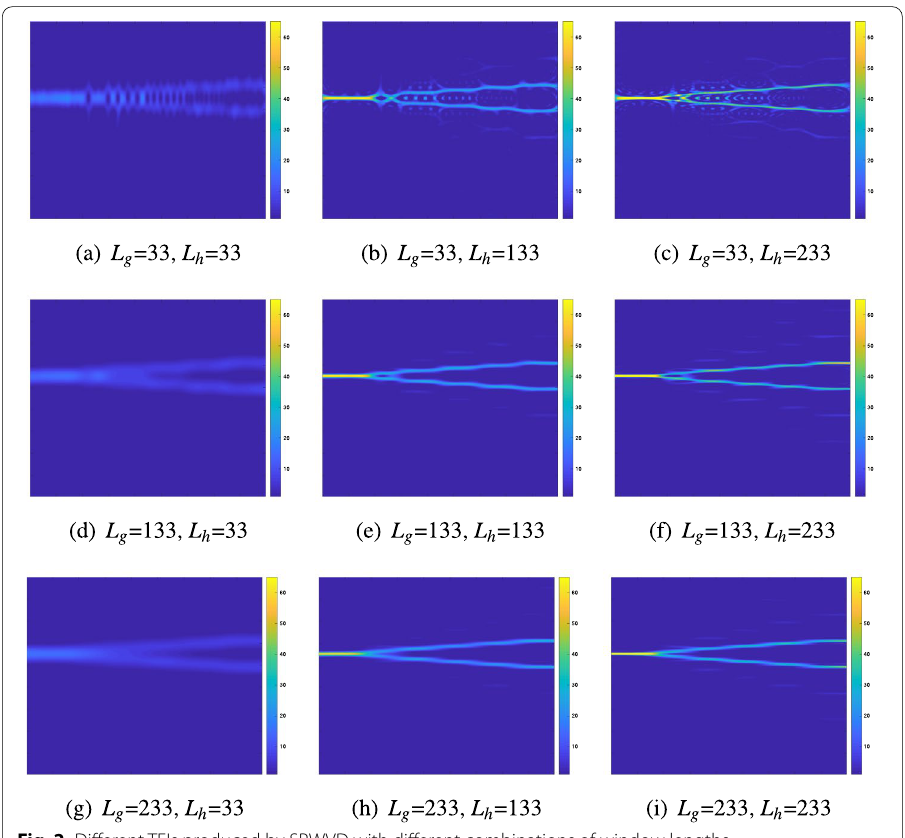
Fig. 2 Different TFIs produced by SPWVD with different combinations of window